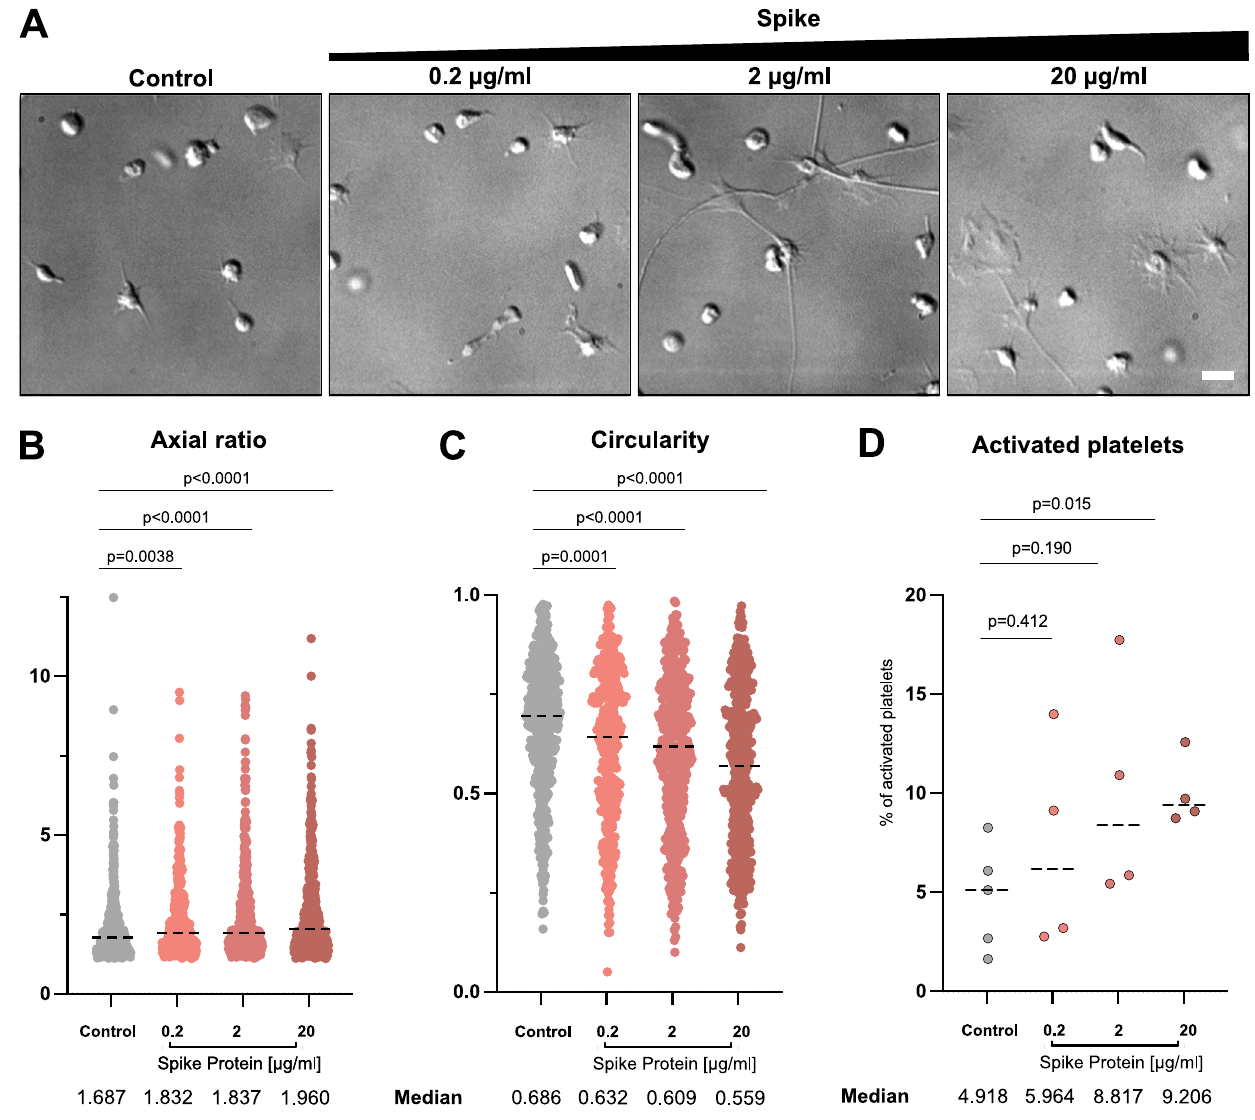
Fig. 2 | Platelet morphology depending on SARS-CoV-2 S protein concentra- tion. A DIC images of platelets in the presence of different amounts of S protein plated onto collagen I-coated surfaces. Scale bar: 5 µ m. B Quanti fi cation of the aspect ratio ofplatelets on collagen I-coatedsurfaces, without and in the presence of different S protein concentrations. The median aspect ratio is shown below the corresponding violin plot. The signi fi cance was determined by two-tailed Mann – Whitney U test. n =442(control), n =359(0.2 µ g/mlSprotein), n =443(2 µ g/ ml S protein), n =391 (20 µ g/ml S protein) platelets examined over at least three independent experiments from different donors. Each dot represents the value from a single platelet. C Quanti fi cation of the circularity of platelets on collagen I-coated surfaces, without and in the presence of different S protein concentra- tions. The median circularity is shown below the corresponding violin plot. The signi fi cancewasdeterminedbytwo-tailedMann – Whitney U test. n =442 (control),